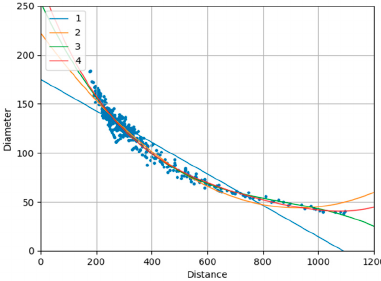
Figure 3. Polynomial equation fitting with different degrees.